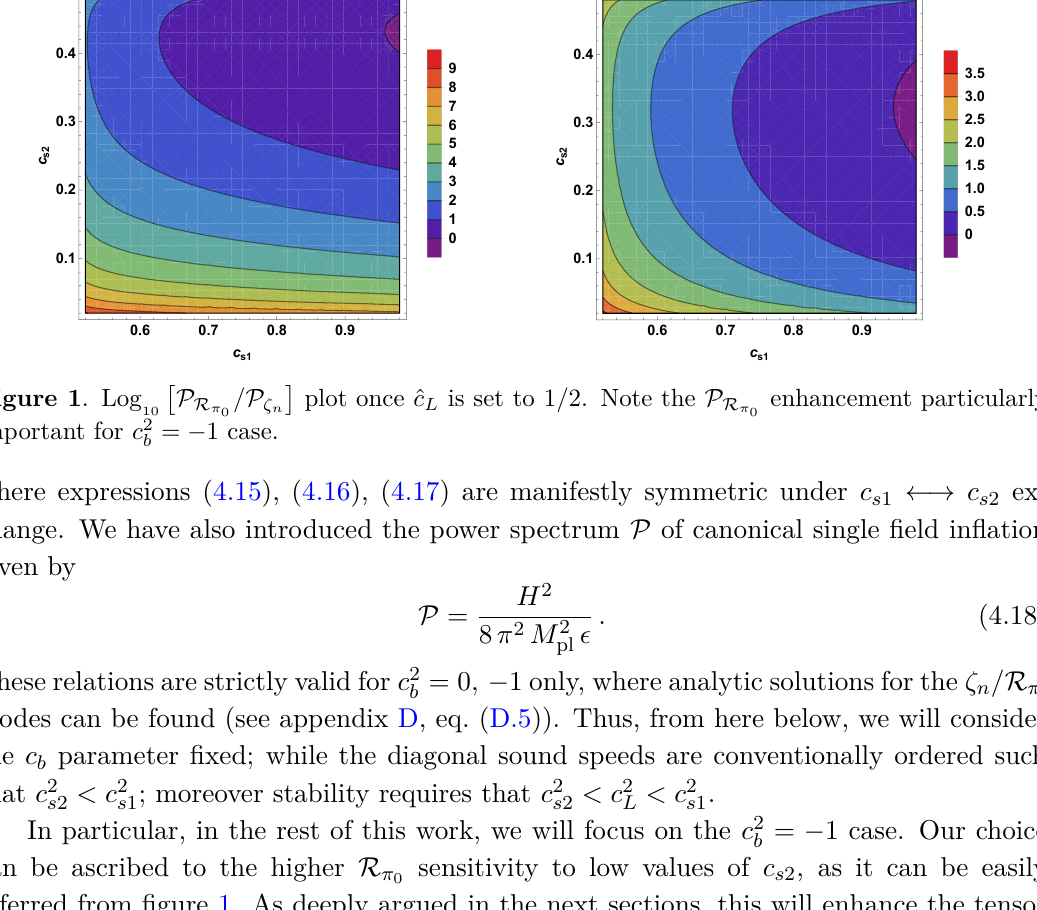
c L is set to 1 / 2 . Note the P R